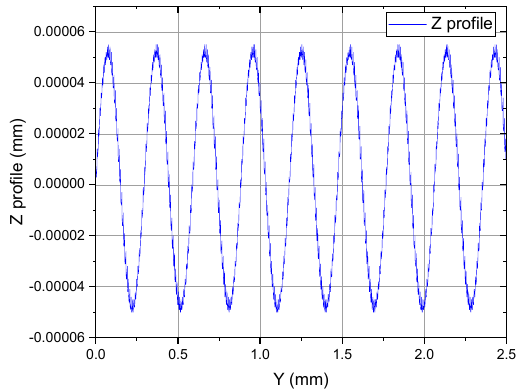
Figure 14. Three-dimensional profile simulation results of planing machining.